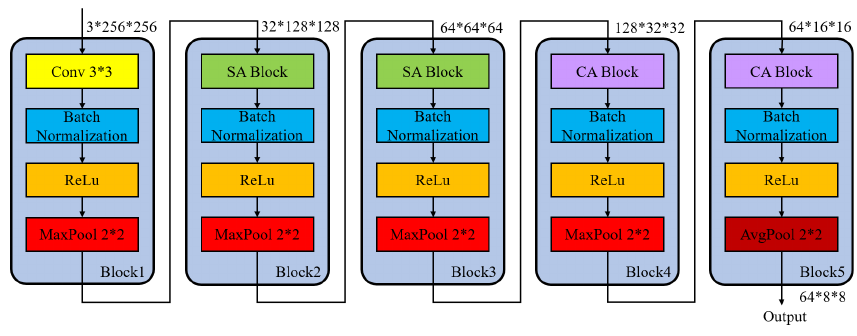
Figure 3. Self-attention embedding network.